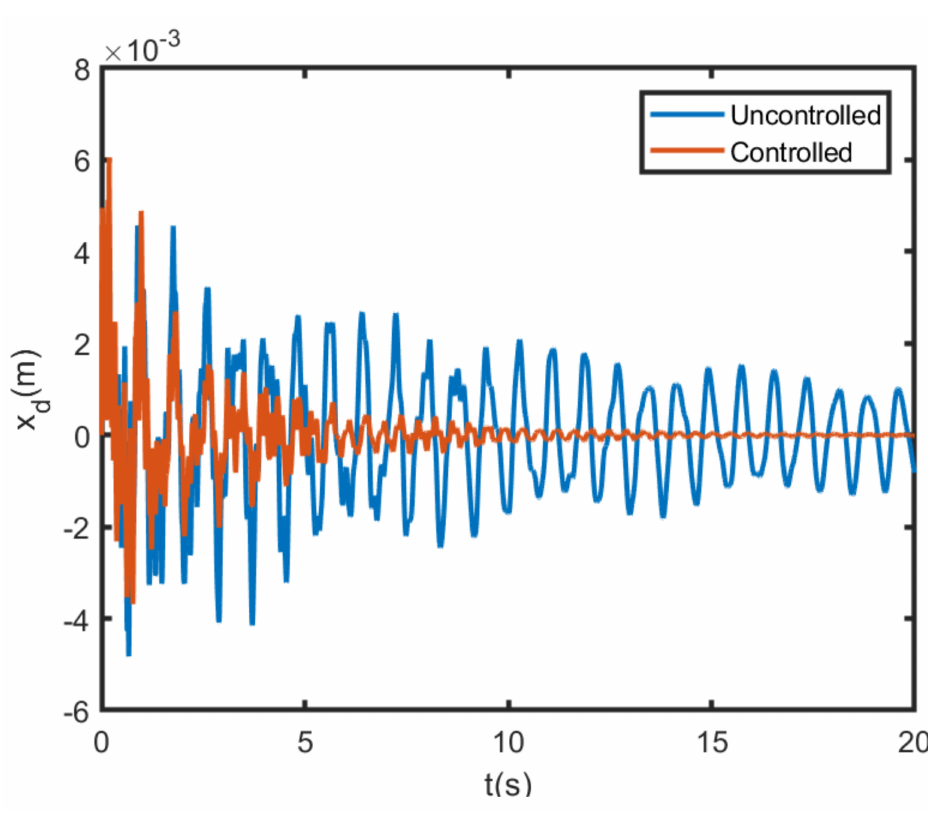
Figure 7. Impulse response by decentralized MIMO NAF controller of the partially submerged plate (H = 0.3